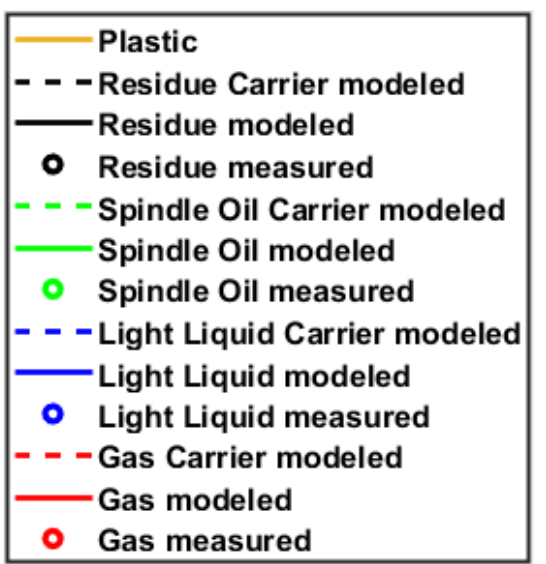
Figure 5. Legend for Figures 6 and 7: The dashed line show the part produced from the carrier fluid and the full lines are the trend of total product, respectively. The points mark the experimental results of this test run.